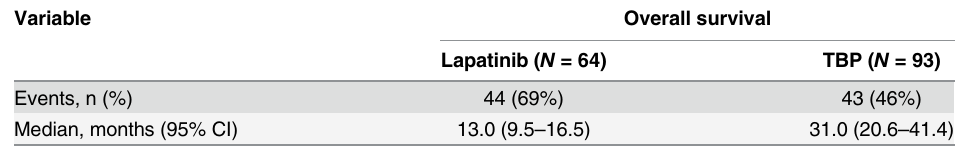
Table 3. Second-line lapatinib vs. trastuzumab univariate analysis.